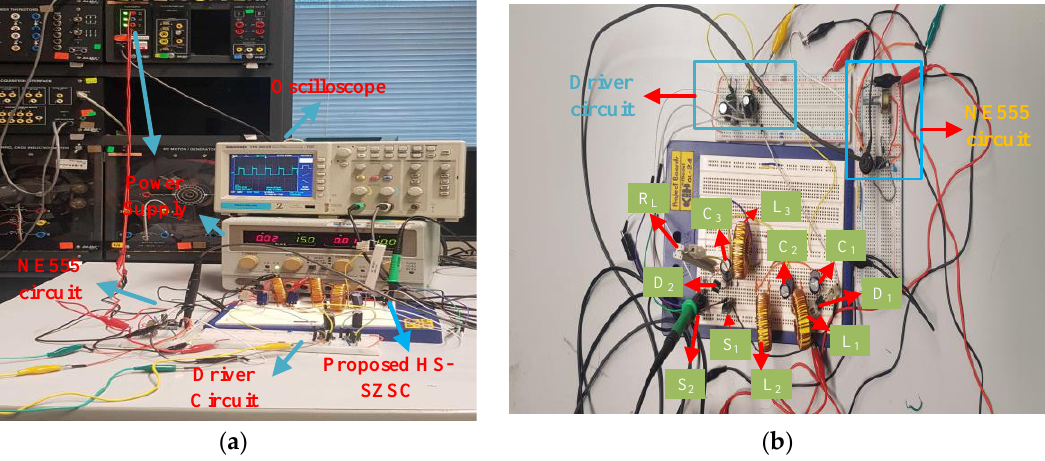
Figure 17. ( a ) Complete experimental setup and ( b ) circuit design of proposed HS-SZC.